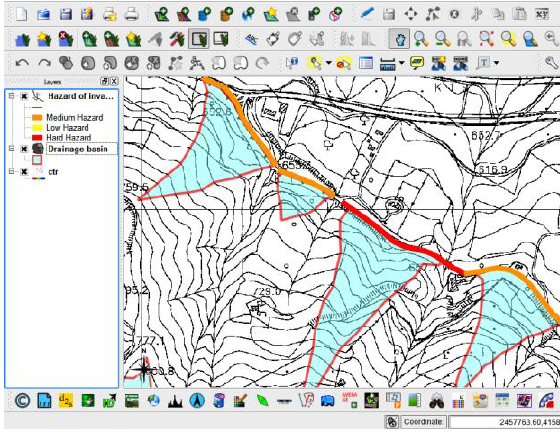
Figure 9. Hazard of water invasion of the